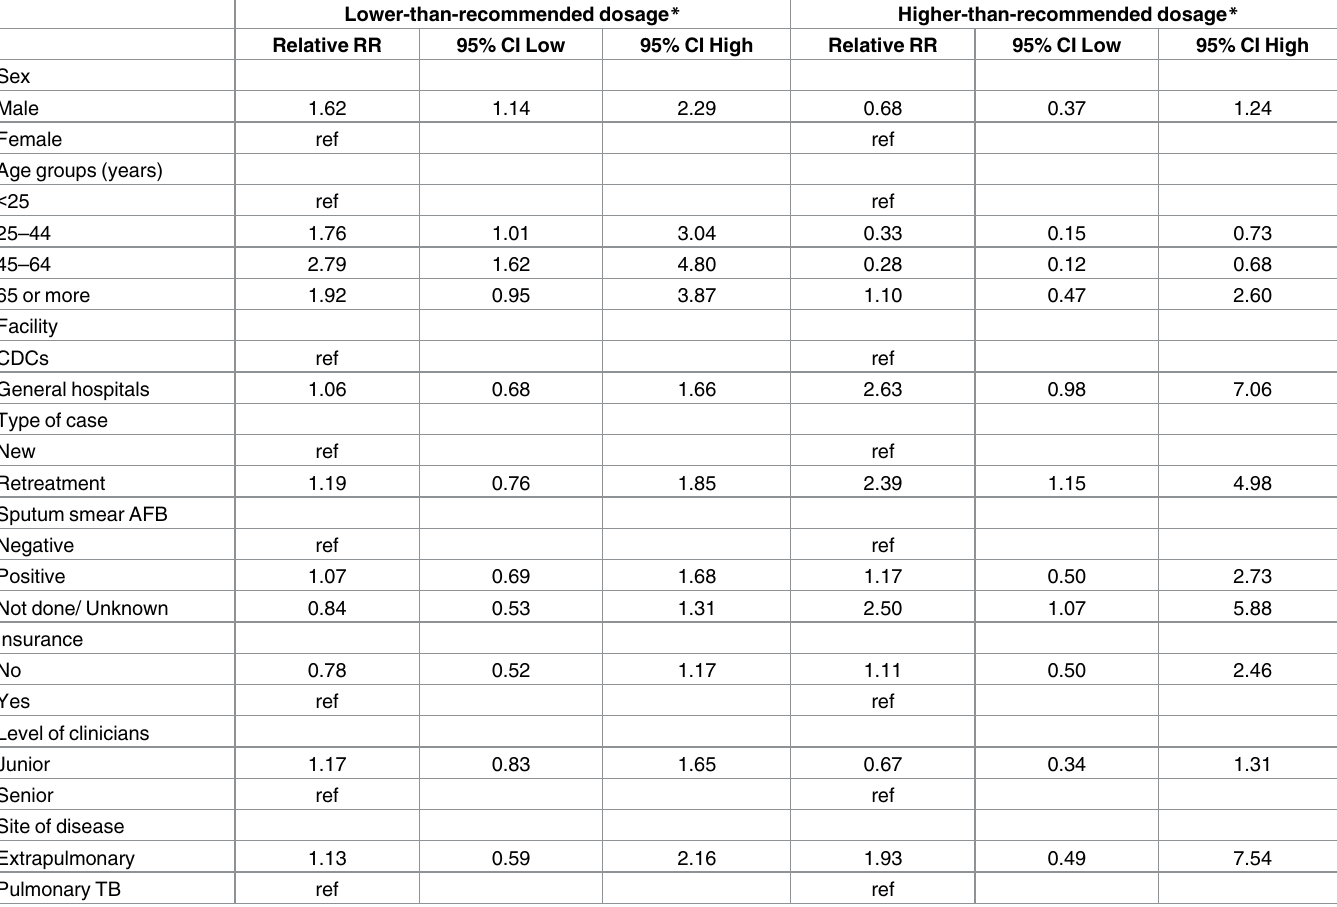
Table 8. Factors associated with inadequate dosing of rifampicin,